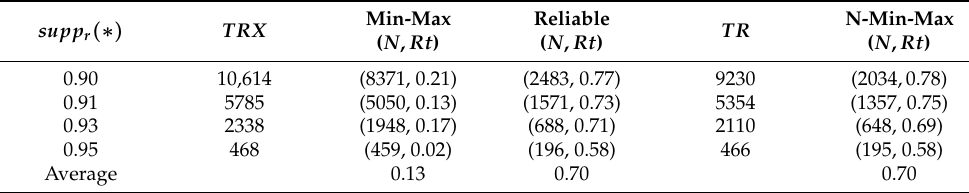
Table A11. The number of approximate rules and reduction in the chess database with confidence 0.5. c ≥